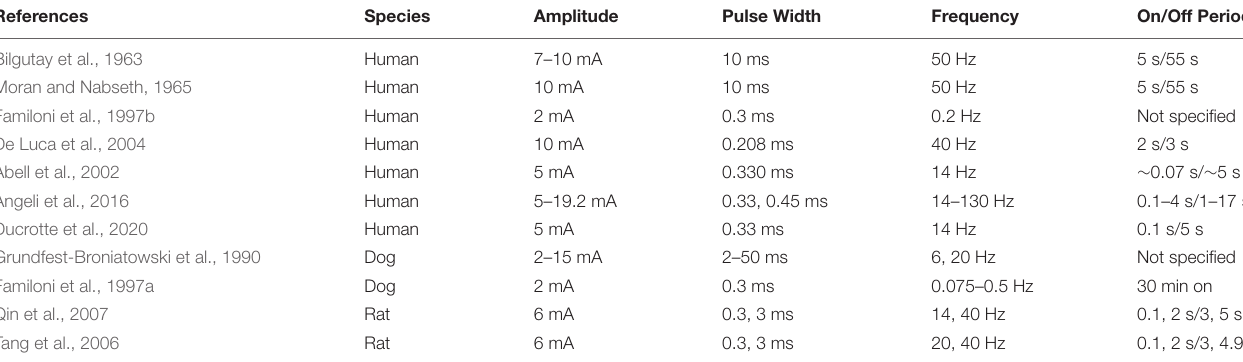
TABLE 2 | Protocols used for gastric